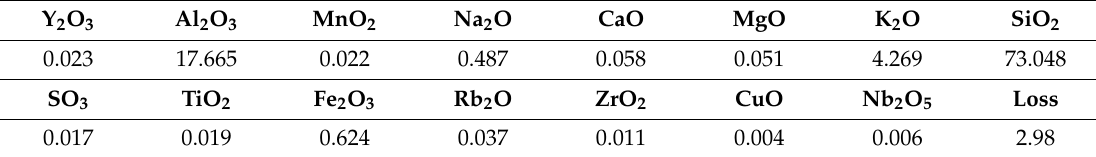
Table 2. The chemical composition of rare earth ore (wt %).